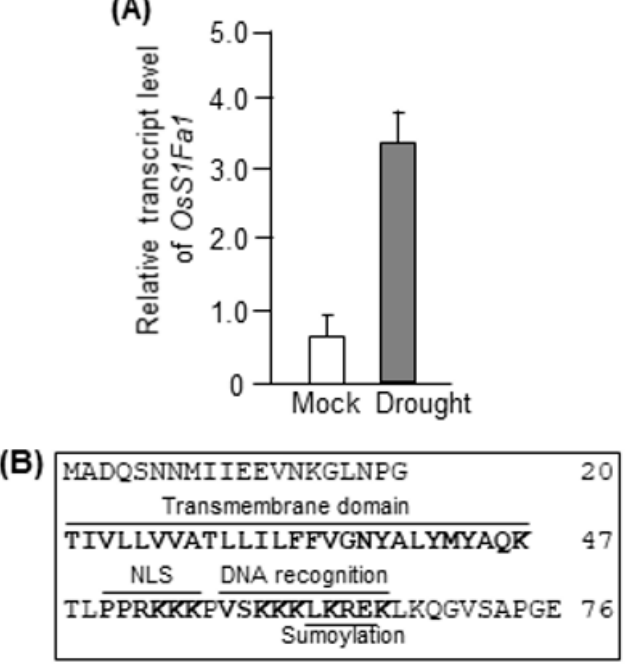
Figure 1. Analysis of OsS1Fa1 transcript levels and the OsS1Fa1 amino acid sequence. ( A ) RT-qPCR analysis of OsS1Fa1 expression in rice seedlings under drought stress. Wild-type (WT) seedlings were grown for 20 d under well-watered conditions by maintaining equal-sized seedlings in pots. Irrigation was withheld on day 20 for the next 19 d. Transcript levels of OsS1Fa1 were examined by RT-qPCR using gene-specific primers. Data represent mean ± standard deviation (SD; n = 3). ( B ) The deduced amino acid sequence of OsS1Fa1. Conserved motifs are indicated in bold.